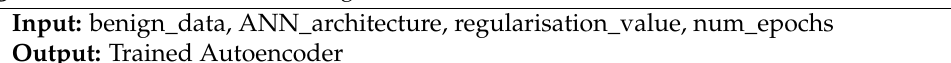
Algorithm 2 Autoencoder Training